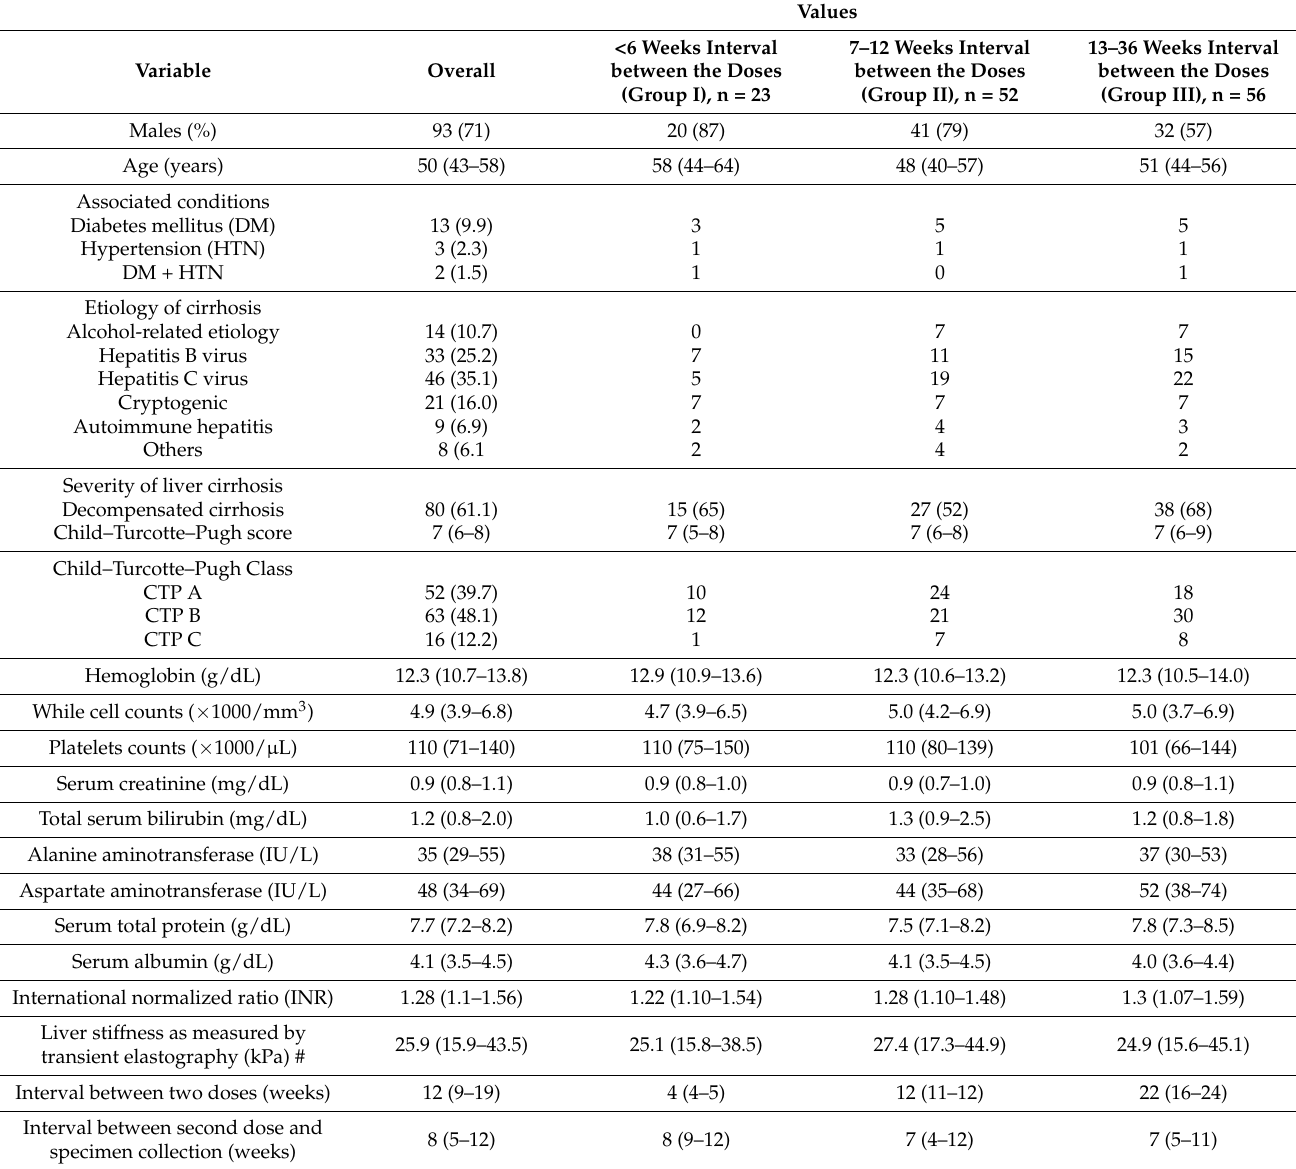
Table 1. Characteristics of the study participants (n =